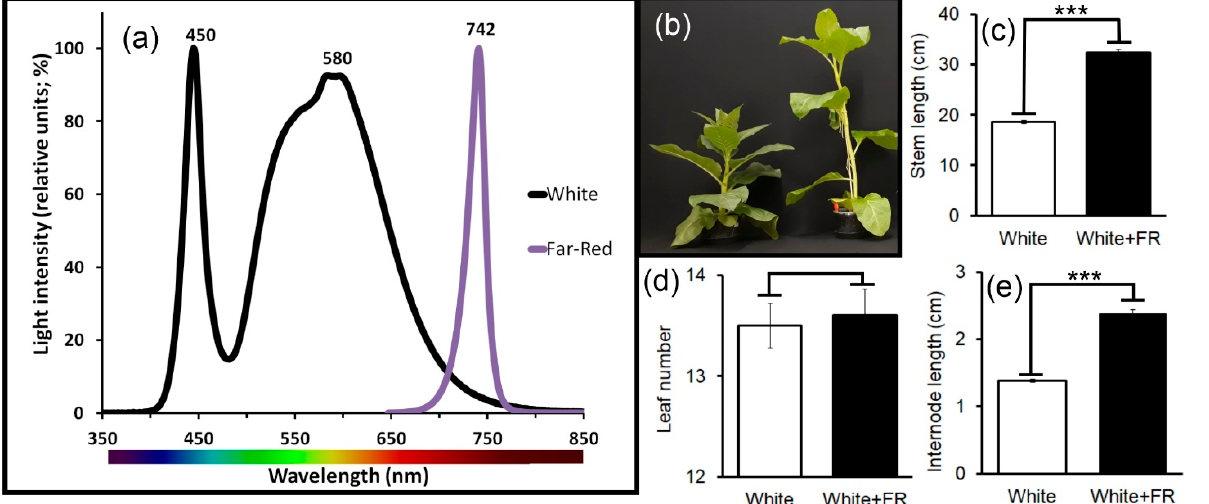
Figure 2. Characterisation of tobacco plants and their growth analysis under distinctive light qualities (White and White + FR) using LEDs (350 at 850 nm), 25 days after the start of treatment. ( a ) Spectral emissivity measurements of LEDs indicating peak wavelength and peak height. Data were normalised to peak = 100%. ( b ) From left to right: tobacco plants grown under White and White + FR conditions. ( c ) Stem length (cm). ( d ) Leaf number. ( e ) internode length (cm). Asterisks (***) indicate statistical differences between treatments determined by the Student’s t ‐ test ( p < 0.001); (n = 10 ± SE).